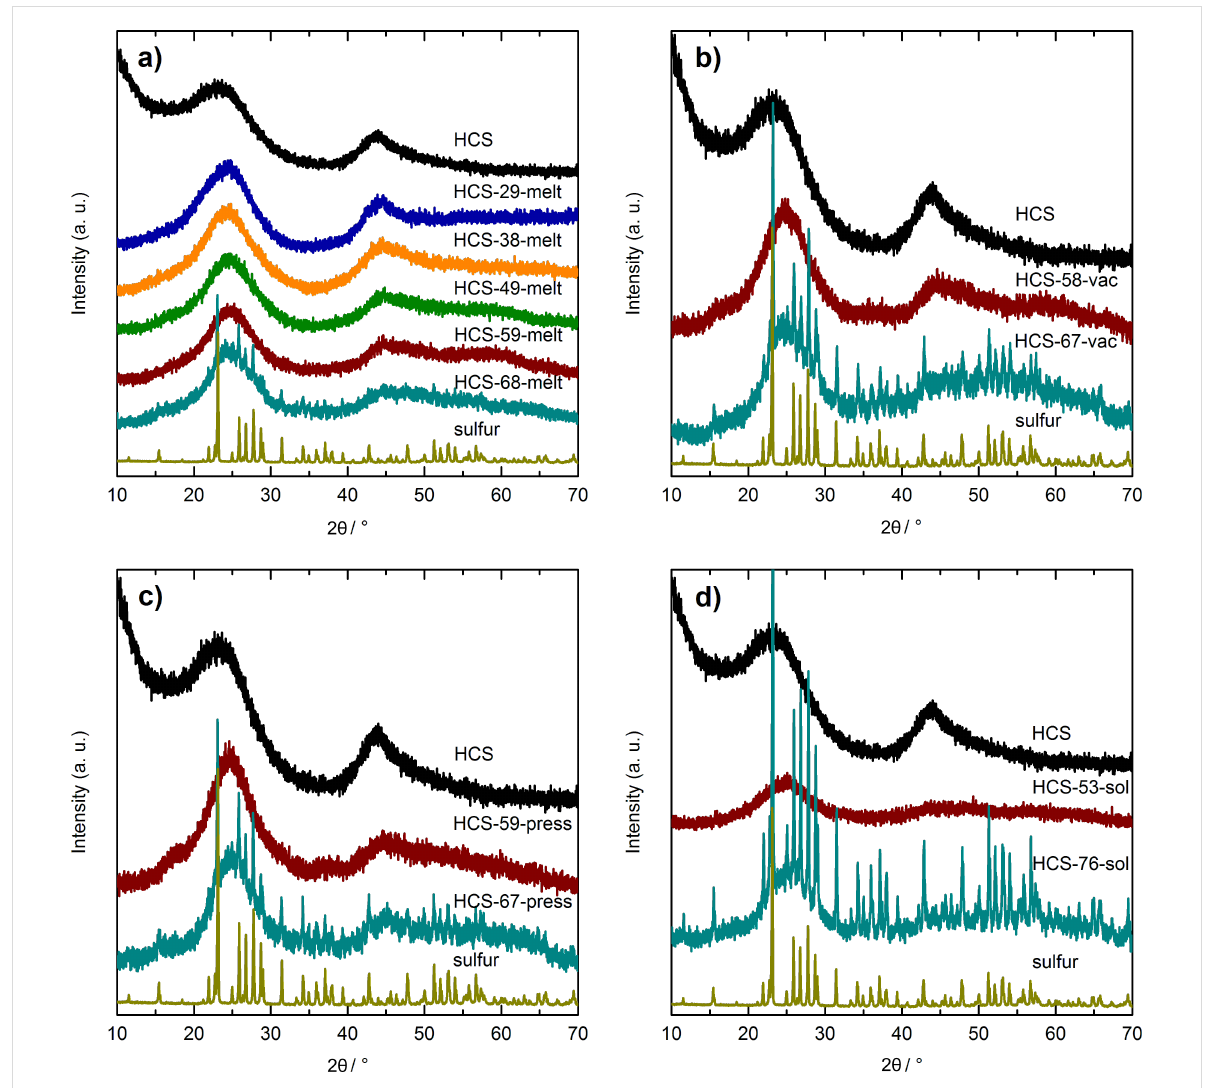
Figure 5: Powder X-ray diffraction patterns of HCS loaded with different amounts of sulfur by a) melt impregnation at ambient pressure, b) melt impregnation in vacuum, c) melt impregnation under increased pressure and d) impregnation from a solution of sulfur in carbon disulfide.